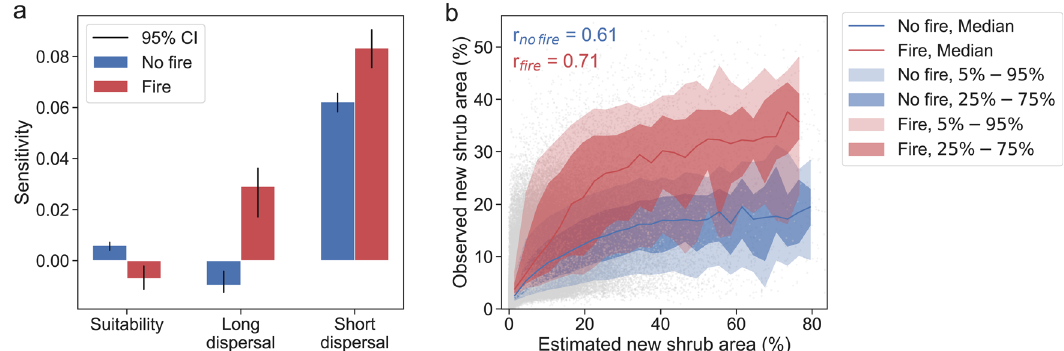
Fig. 2 Dispersal and fi re explain shrub expansion during 1984 – 2014. a Sensitivity of new shrub area to environmental suitability and probabilities of seed arrival via short- and long-distance dispersal at locations with (red bars) and without (blue bars) fi re. Colored bars denote the average and vertical black lines denote range of the 95% con fi dence interval of the regression coef fi cients across optimal dispersal kernel parameters ( n = 533). b Observed and estimated new shrub area, i.e., areal fraction at a 4 km scale, in 2014 at locations with (red) and without (blue) fi re. The lines and shaded bands represent the medians and ranges of observed new shrub area (gray dots) for each bin of estimates with a width of